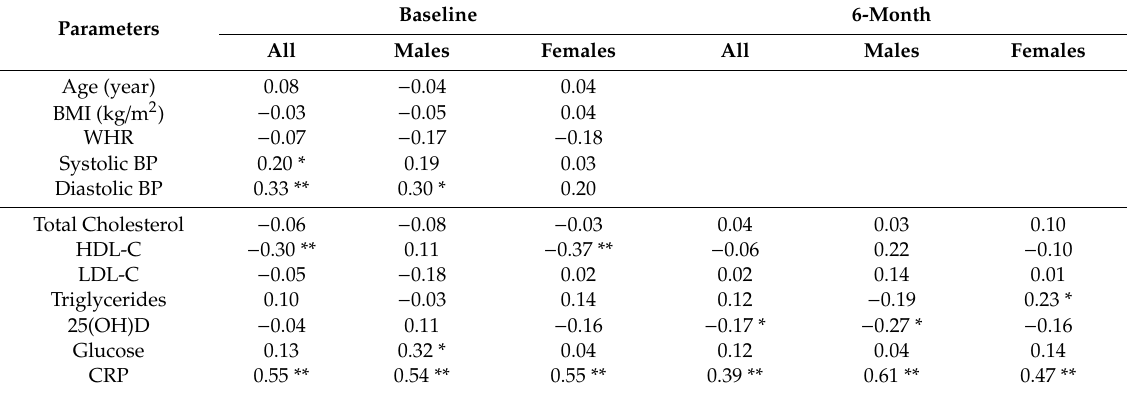
Table 4. Bivariate associations of SAP among responders at baseline and after 6-month